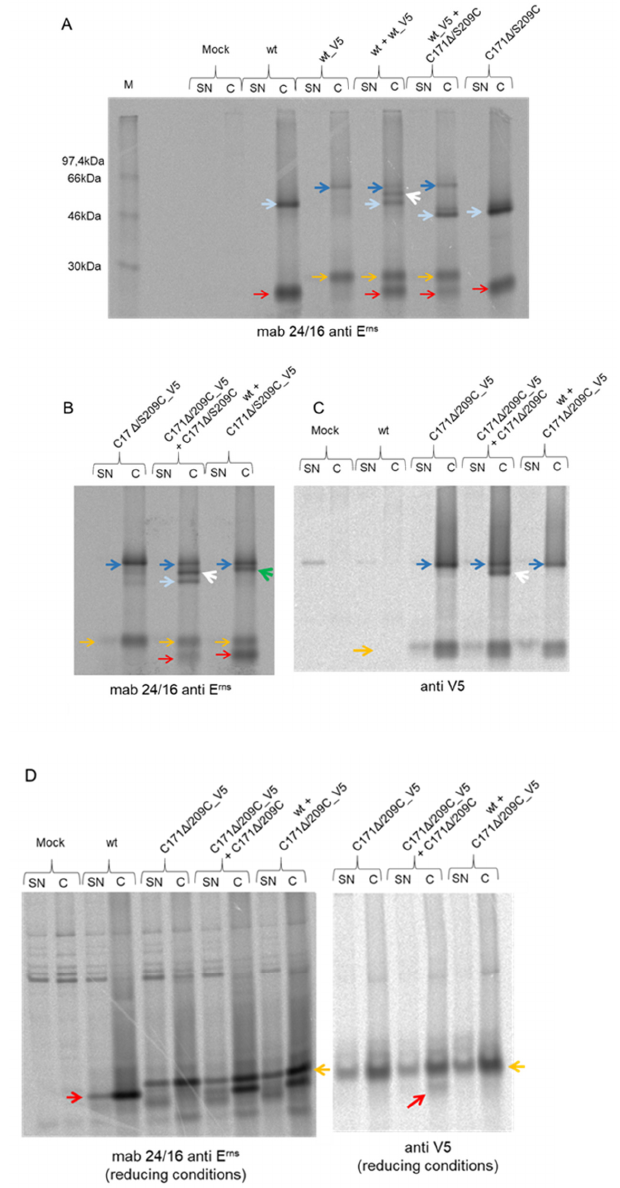
Figure 4. Co-immunoprecipitation experiments of E rns wt and mutants with or without carboxy-terminal V5-tag. ( A ) wt E rns and wt E rns with V5-tag (wt_V5) were expressed separately or together with each other. In addition, wt_V5 was expressed with E rns mutant C171 ∆ /S209C. The proteins were labeled in situ, precipitated with mab 24/16 against E rns , and analyzed by nonreducing SDS-PAGE. Red arrows: E rns monomers; orange arrows: E rns _V5 monomers; light blue arrows: E rns dimers; dark blue arrows: E rns _V5 dimers; white arrow: heterodimers of E rns and E rns _V5. Please note that the homodimer composed of two mutant proteins moves considerably faster on the gel than the wt-wt homodimer ( B ) Equivalent to ( A ), but with mutant C171 ∆ /S209C_V5 instead of wt_V5. The green arrow points at a band running close to the C171 ∆ /S209C_V5 homodimer that does not comigrate with any of the control bands. ( C ) Same cell extracts/supernatants as in ( B ), but precipitated with an anti-V5 serum. The band marked with a green arrow in ( B ) is not detected here. ( D ) Equivalent to ( C ), but with SDS-PAGE conducted under reducing conditions. In addition to extracts of cells transiently expressing the desired proteins, we also analyzed the supernatant of these cells since E rns is known to be secreted to a certain extent into the cell free supernatant. However, this analysis did not yield results influencing the conclusions of the experiments and are therefore not discussed in